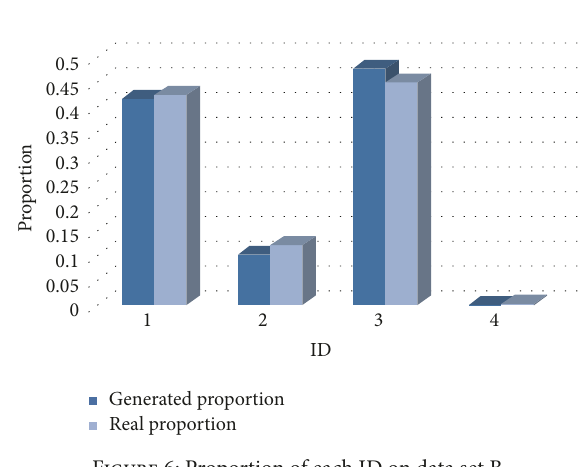
Table 4: Performance and description on data set B.